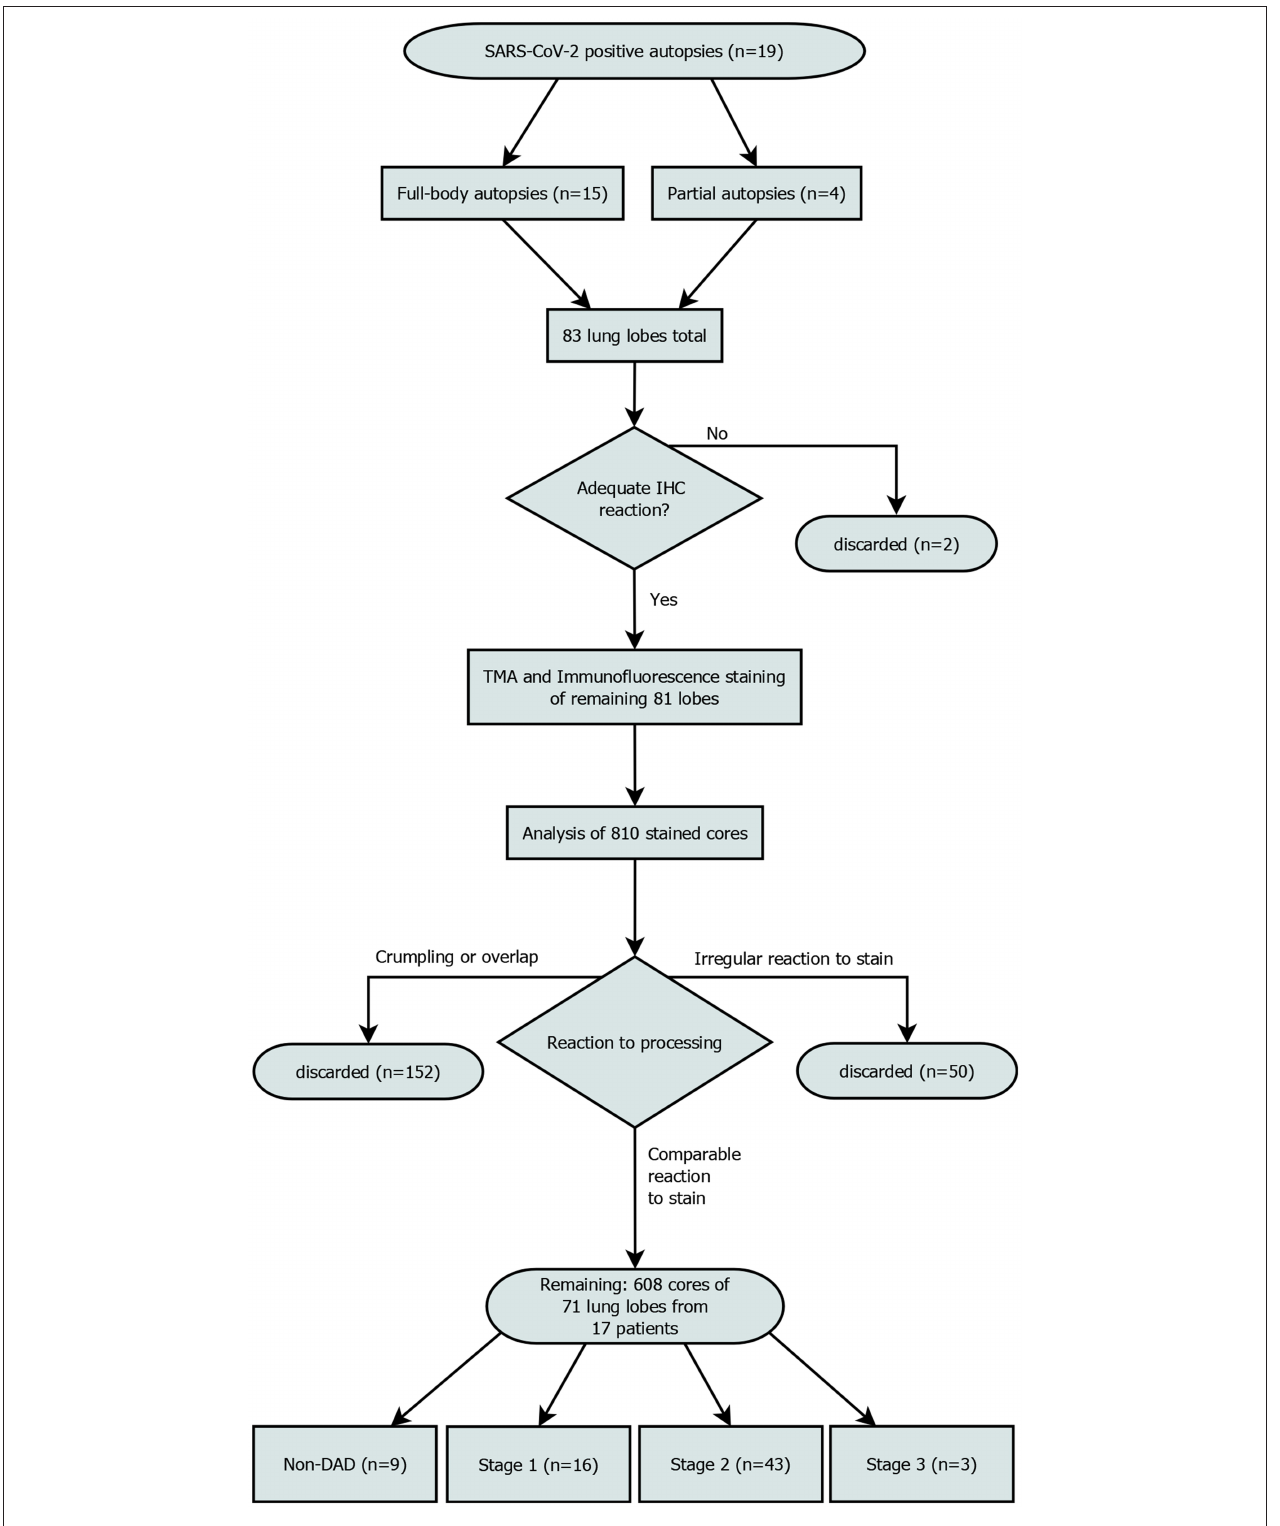
FIGURE 1 | Patient enrollment flowchart. Out of 810 planned cores, 608 were included in the final analysis. “Irregular reaction to stain” refers to cores from a single patient, that showed a reaction to the stain that was not comparable to the rest of the cores. All samples of this patient were discarded.